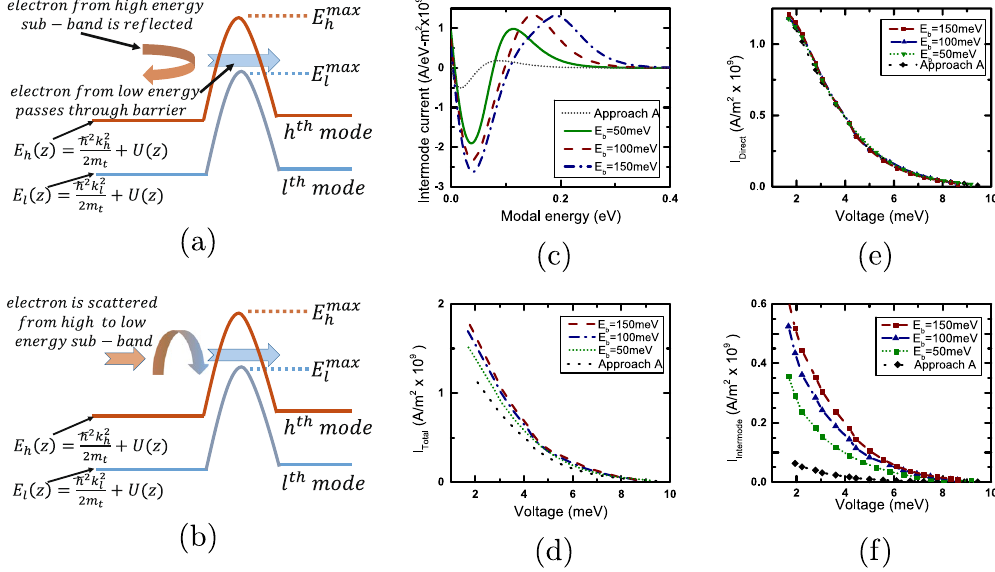
Figure 4. Demonstration of performance improvement due to inter sub-band coupling in energy filtering based bulk thermoelectric generators. ( a , b ) Schematic diagram illustrating electronic transport through a  respectively. ( a ) device with two sub-bands: the l th and the h th sub-band with lateral momentum  k and k l h Electronic transport when the sub-bands are uncoupled. In this case, the electrons from the h th sub-band are completely reflected from the barrier if the total energy of the electron is lower than E hmax . ( b ) Electronic transport when the sub-bands are coupled. In this case, the electrons from the h th sub-band (with energy between E lmax and E hmax ) may be scattered to the low energy sub-bands between the hot contact and the barrier interface and subsequently flow towards the cold contact. ( c ) Plot of intermode coupling current vs. modal (sub- band) energy per unit area per unit energy in case of bulk generators at the maximum power. ( d – f ) Current profiles per unit area at the maximum power at different bias voltages ( V ) considering acoustic phonon scattering. Plot of ( d ) the total current, ( e ) the current propagating directly between the contacts without changing sub-bands and ( f ) the intermode coupling current. Simulations are done for a 20 nm long device. For Approach B, an embedded Gaussian energy barrier is used ( σ w = 2.7 nm ). An enhancement in generated power with barrier height results from an enhancement in the intermode coupling